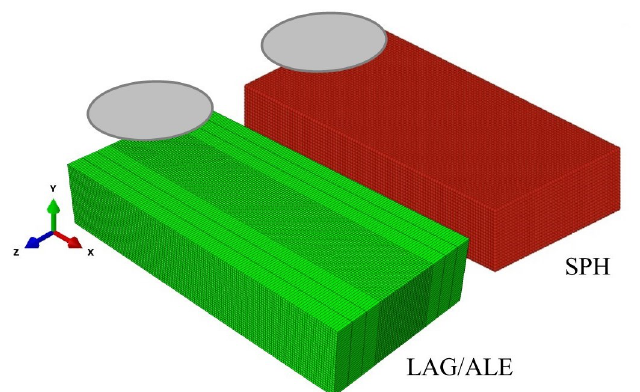
Figure 11. Discretized workpiece with element spacing d e in the center part for the LAG/ALE models and particle spacing d p for the SPH